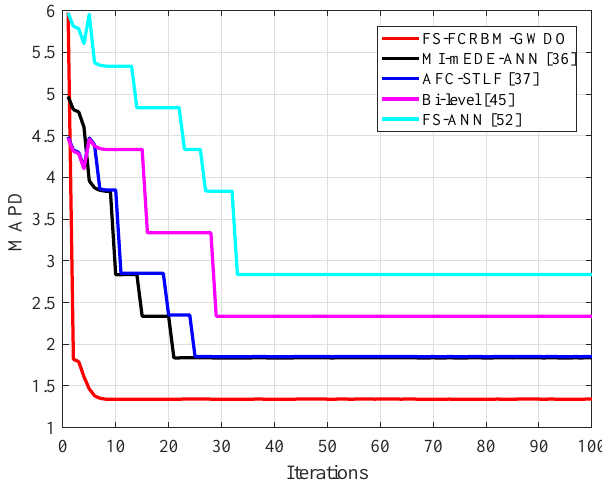
Figure 13. Convergence speed analysis of the proposed hybrid FS-FCRBM-GWDO model and benchmark models for 100 iterations on FE power grid hourly load data.